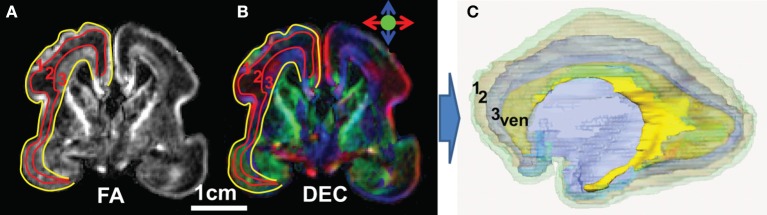
Subdivision of the 20 PMW human fetal brain cerebral wall into three layers. (A) Coronal image of the FA map; (B) coronal image of the direction-encoded colormap map; and (C) three-dimensionally reconstructed three layers of a 20 PMW fetal brain. In (A) and (B), red curves separate the three layers in the cerebral wall based on FA contrast and yellow curves separate the cerebral wall from others. In (C), transparent layer 1 (green), layer 2 (light brown), and layer 3 (blue) are cortical plate (with marginal zone), subplate and inner layer (Huang et al., 2013), respectively. Ventricle (yellow) is also displayed in (C) as anatomical reference. ven: ventricle.